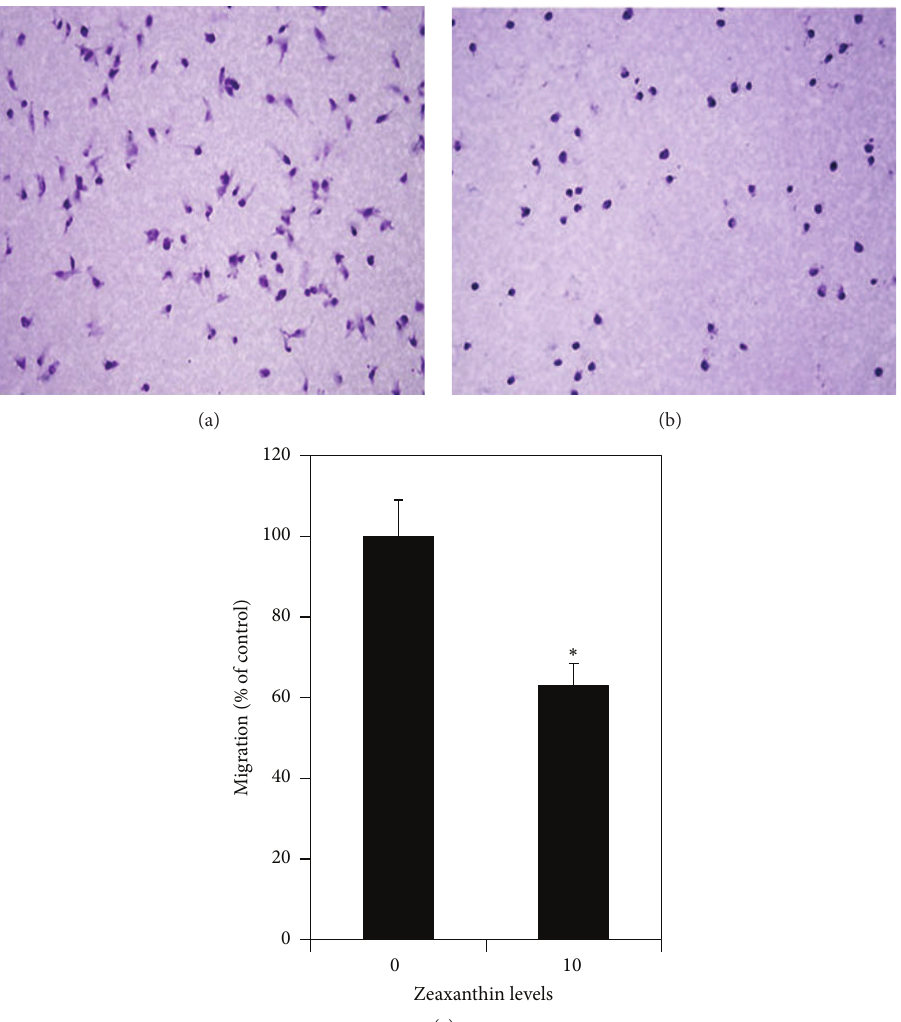
Figure 3: Zeaxanthin inhibits migration of UM cells by using Boyden chamber assay. Cells (C918) were seeded into the upper chamber and the lower chamber was filled with DMEM with 10% serum (see Material and Methods). After being cultured with (b) or without (a) zeaxanthin at 10 𝜇 M for 8 h, the migration of UM cells was measured by counting the migrating cells on the lower surface of the membrane at 10 fields. Photos were taken by a light microscope at × 200. Numbers of migrating cells in cultures without zeaxanthin and with zeaxanthin were 107.3±9.75 and 67.2±6.16 cells (mean ± SD), respectively, and expressed at the bar graph as 1.00±0.09 and 0.63±0.06 (percentages of the control), respectively. Zeaxanthin significantly inhibited the migration of UM cells ( 𝑛 = 3 , 𝑃 < 0.05 ) (c). ∗ 𝑃 < 0.05 , versus control (cells cultured without